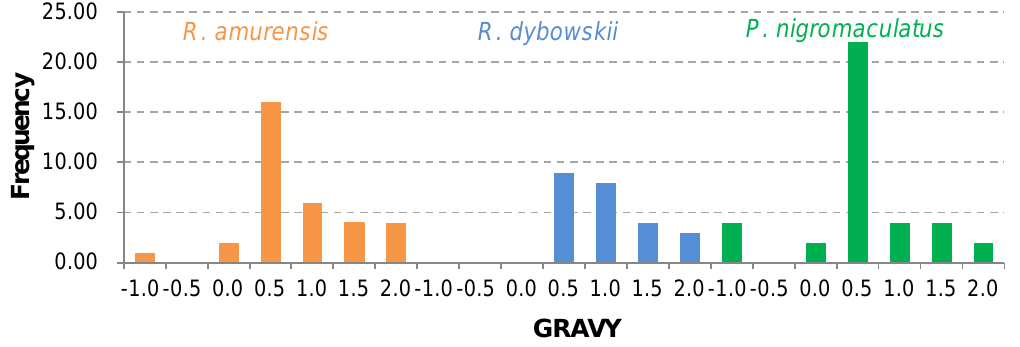
Figure 8. Frequency distribution of hydrophobicity predicted for all antimicrobial peptides (AMPs) isolated from the three anuran species.